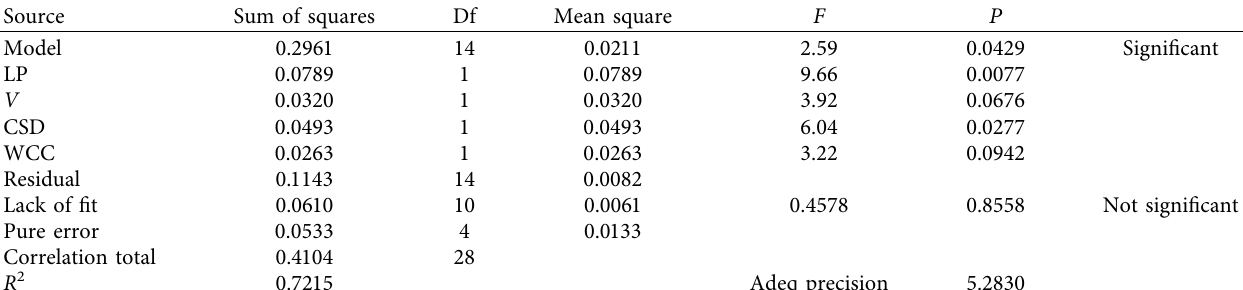
Table 6: Variance analysis of the surface flatness.